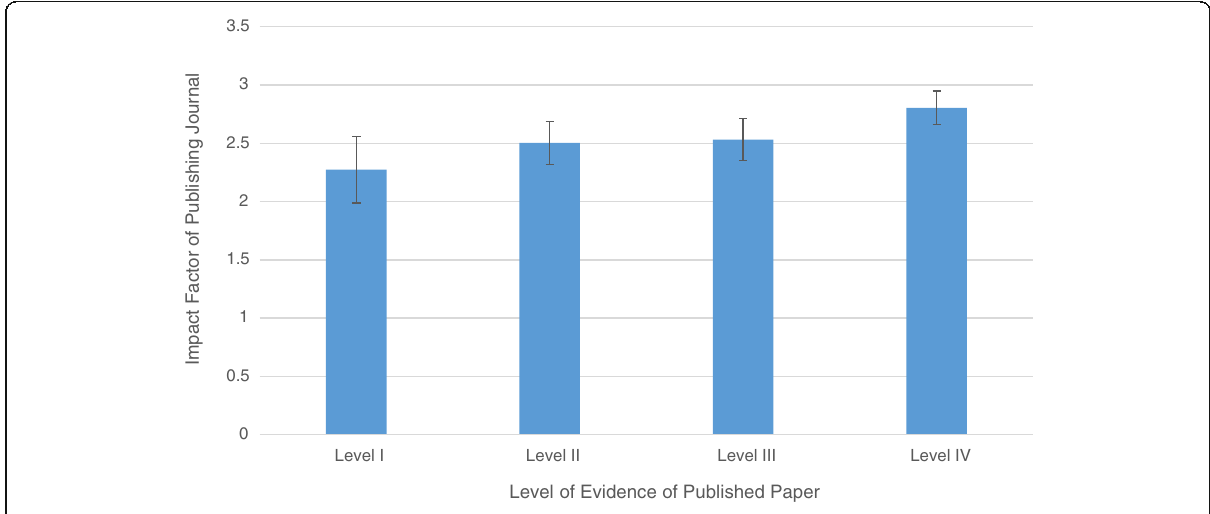
Fig. 3 Mean ± SEM impact factor of the publishing journals by level of evidence of the published